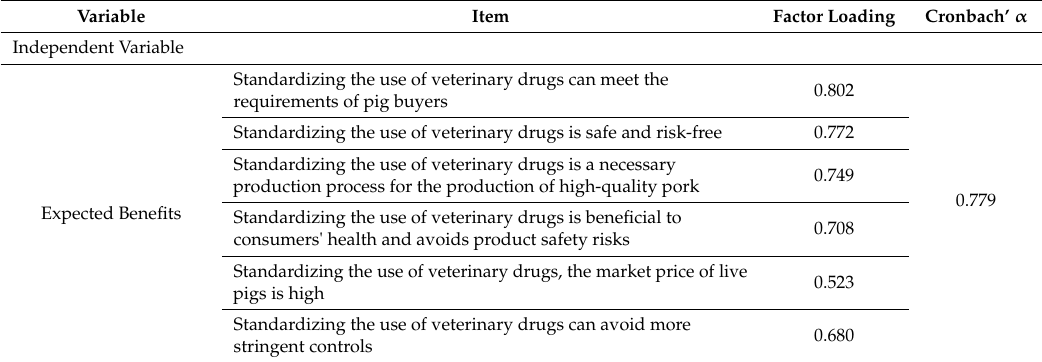
Table 2. Core variable description and